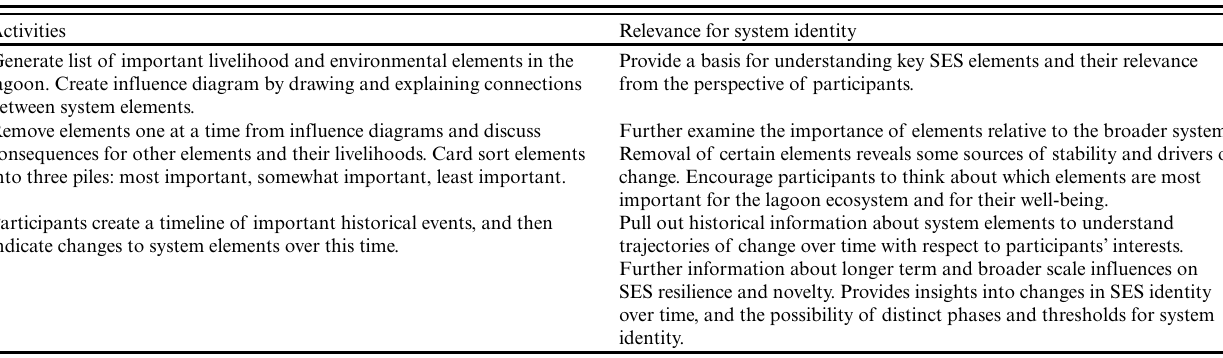
Table 3 . Steps and activities in the focus